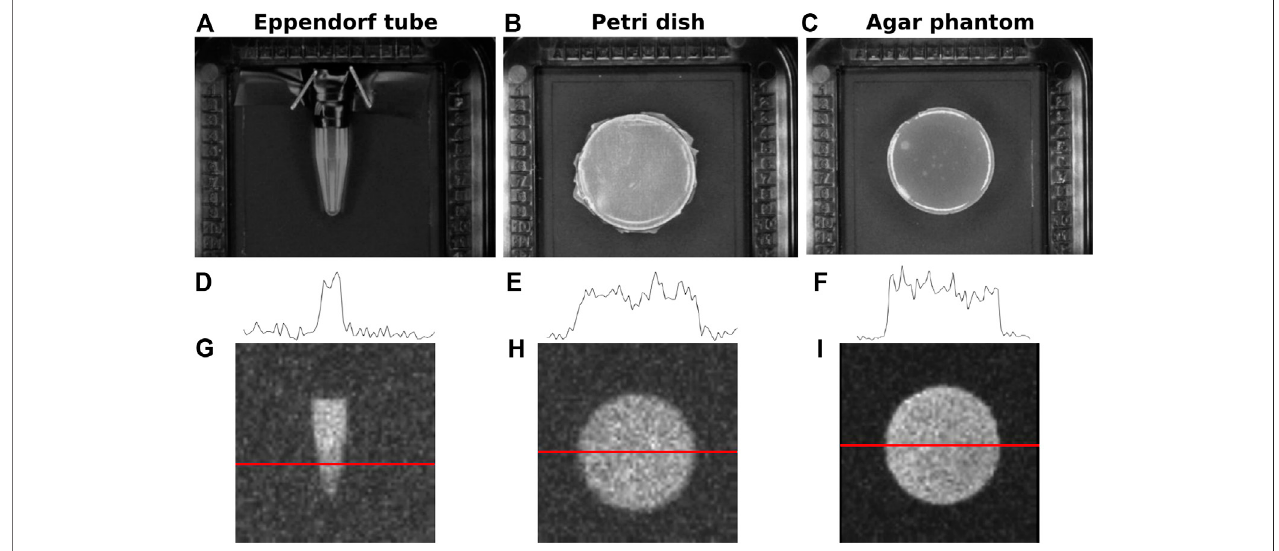
FIGURE1| Geometriestestedforactivitycon fi nement: (A) 1.5 mlEppendorftubes, (B) blackPetridishessealedwithatransparentparaf fi nlid, (C) agarbasedsolid phantoms. Corresponding pro fi les (D – F) and CLI images (G – I) are shown